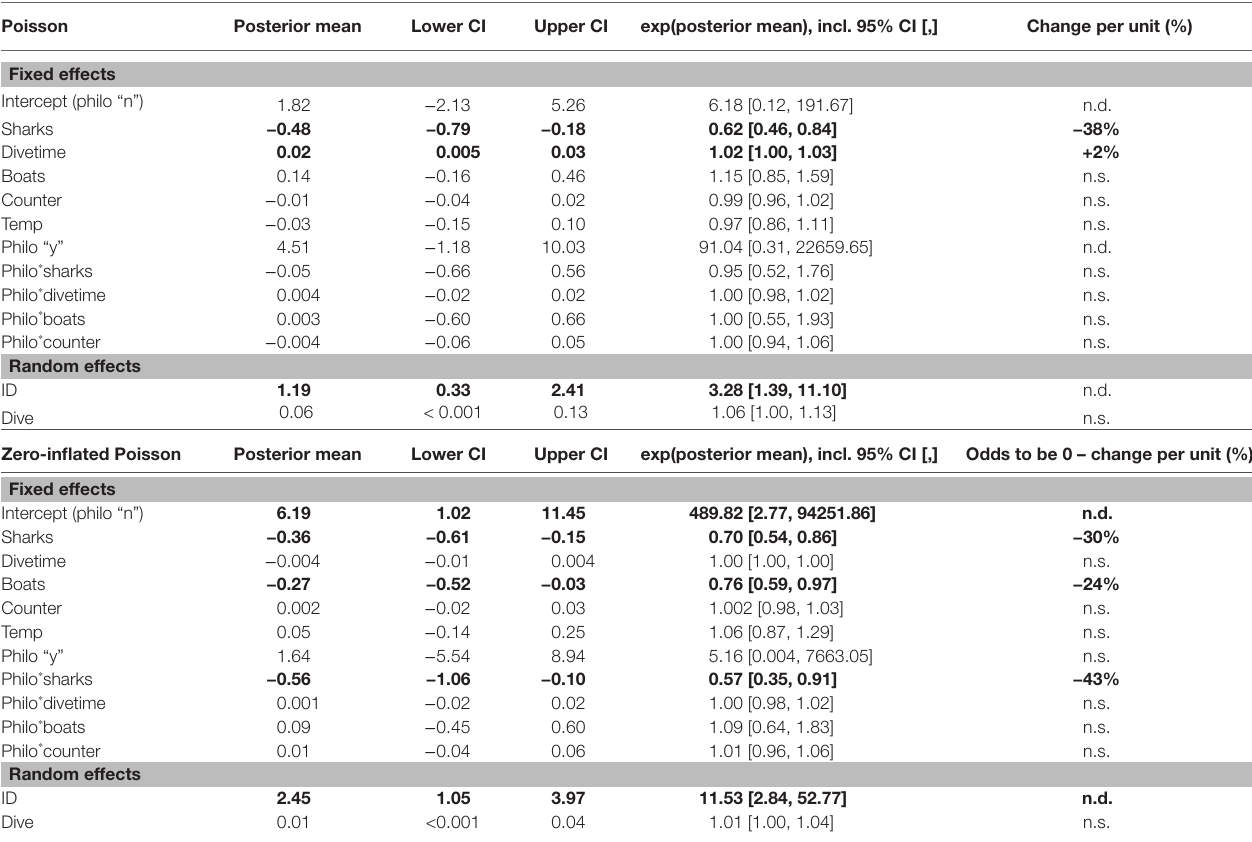
TABLE 4 | Summary of the zero-inflated Poisson GLMM for the presence time of great hammerhead sharks ( S. mokarran ) during provisioning dives (model 3).